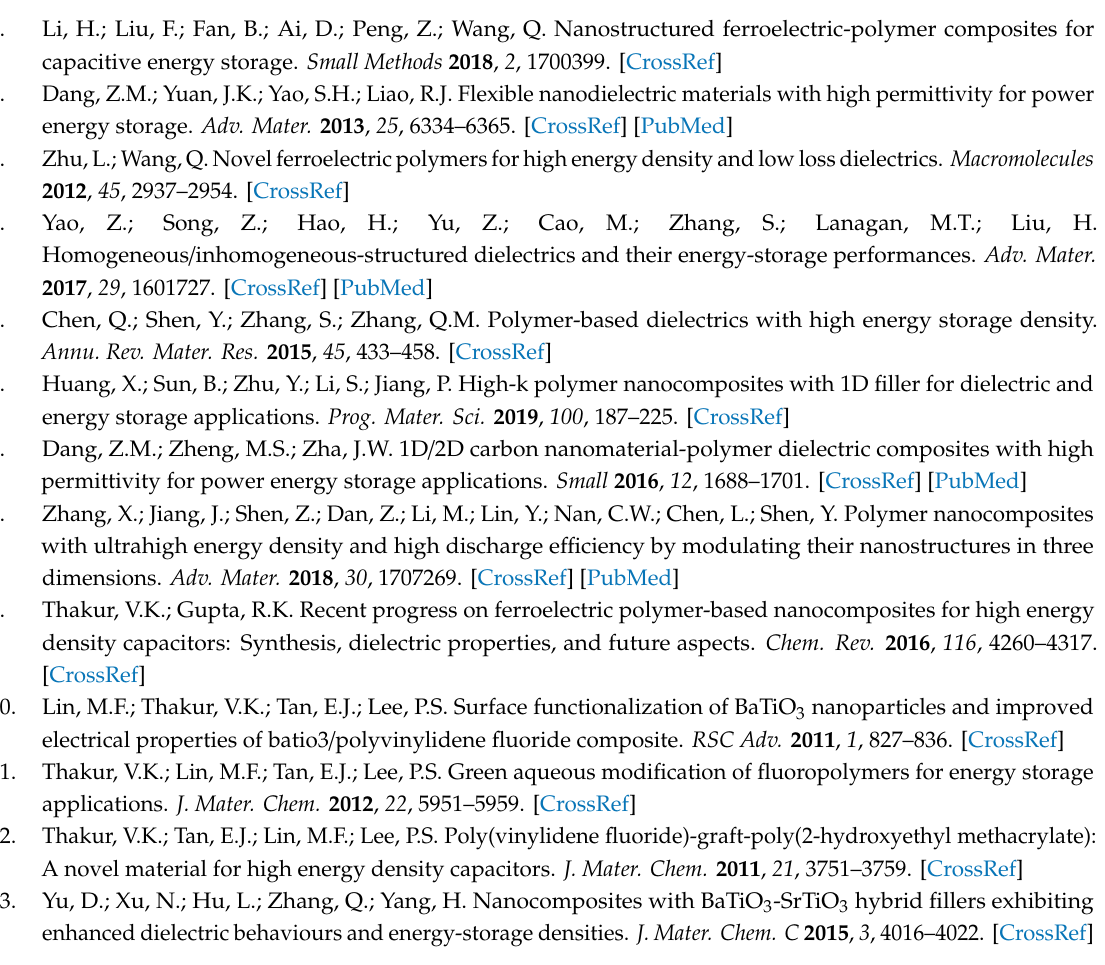
Figure S1: Frequency dependence dielectric performances of BT / P(VDF-HFP) composites. Figure S2: Digital photograph of 20 vol% FB / P(VDF-HFP) composites in (a) unbent and (b) bent statuses. (c) Comparison of dielectric properties of the original 20 vol% FB / P(VDF-HFP) composites and bent composites for 1000 cycles. Table S1: Some research studies related to BaTiO 3 in PVDF-based